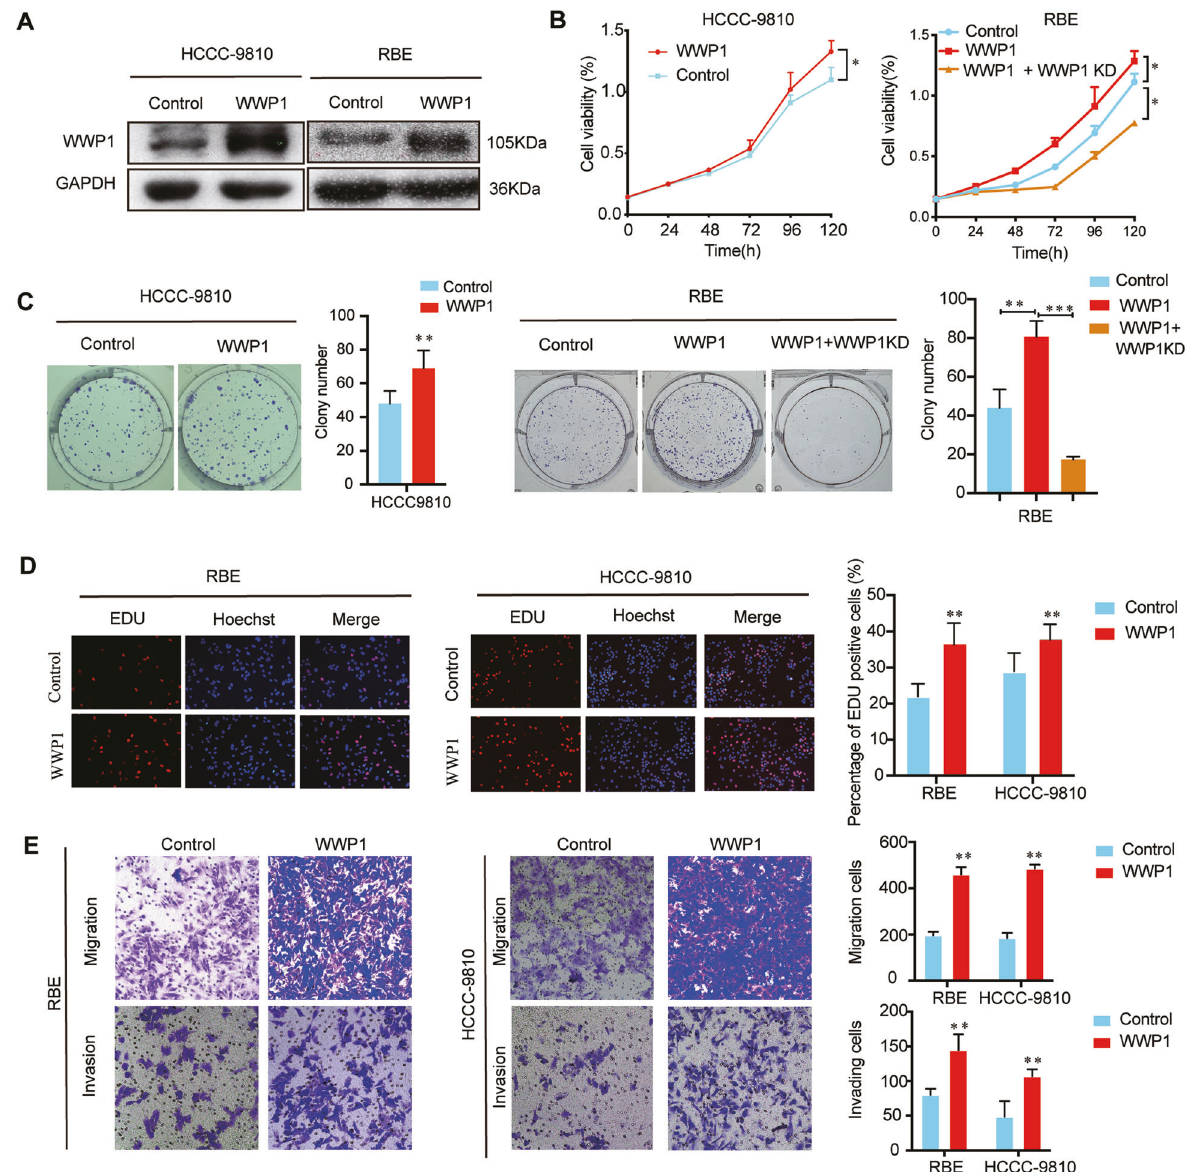
Fig. 3 WWP1 overexpression promoted proliferation, migration, and invasion of ICC cell lines in vitro. A The ef fi ciency of WWP1 overexpression was estimated by western blotting. B CCK-8 assay, C colony formation assay, D EdU assay were applied to estimate the proliferation of HCCC-9810 and RBE cells after WWP1 overexpression, n = 3. Silencing WWP1 again in RBE cells overexpressed WWP1 protein reversed the ability of proliferation ( B , C ). E Transwell assays were performed to detect the migration and invasion of HCCC-9810 and RBE cells after WWP1 overexpression. * P < 0.05, ** P <